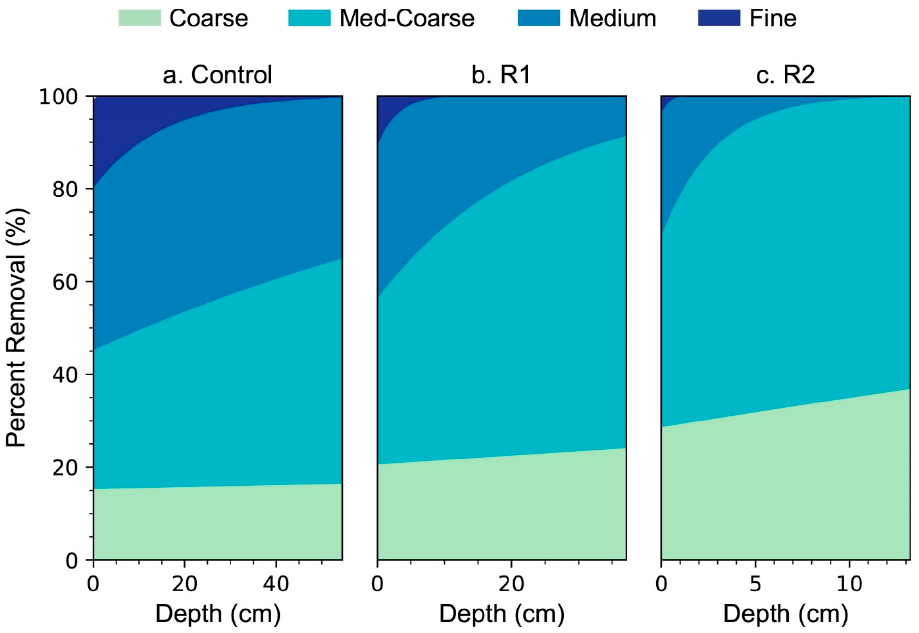
Figure 6. Modeled percent removal of E. coli by depth at varying sand media for ( a ) a traditional BSF design (control); ( b ) a 40% reduced-height design (R1); and ( c ) a 70% reduced-height design (R2). Color fills are used to represent a range between given media such as that between fine and medium sand. Note the x-axis scales are different.